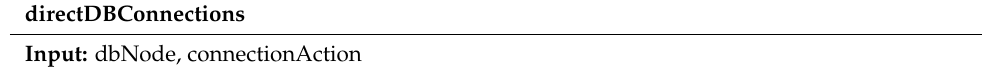
Listing 1. Pseudocode of the connection directing algorithm at proxy